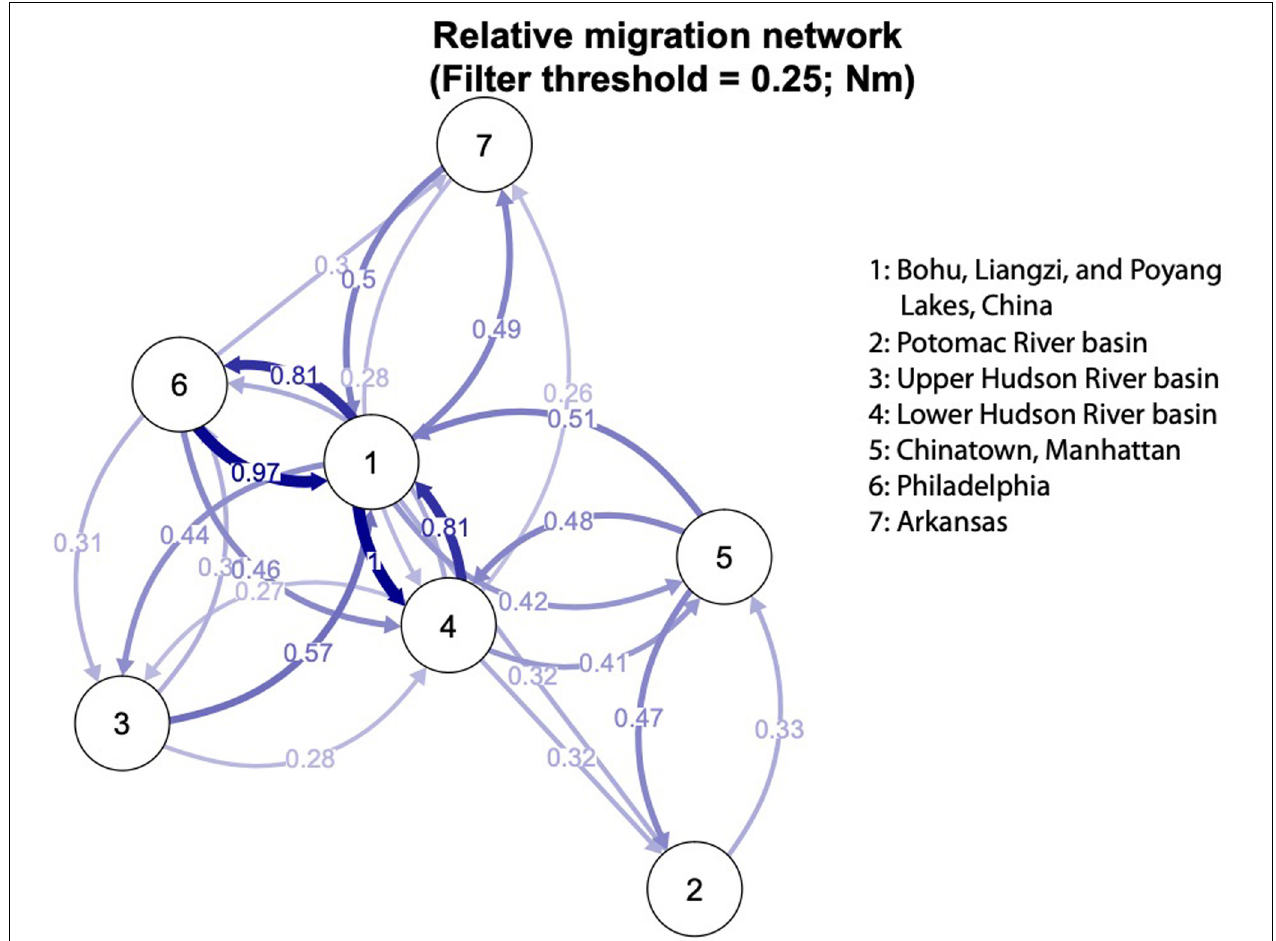
FIGURE 5 | Relative migration network of C. argus putative